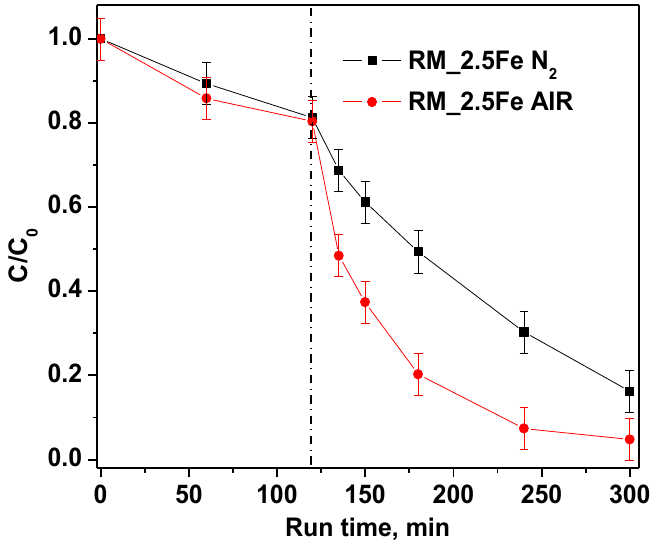
Figure 12. Effect of air and nitrogen atmosphere on photocatalytic discoloration of crystal violet using RM_2.5Fe photocatalyst.